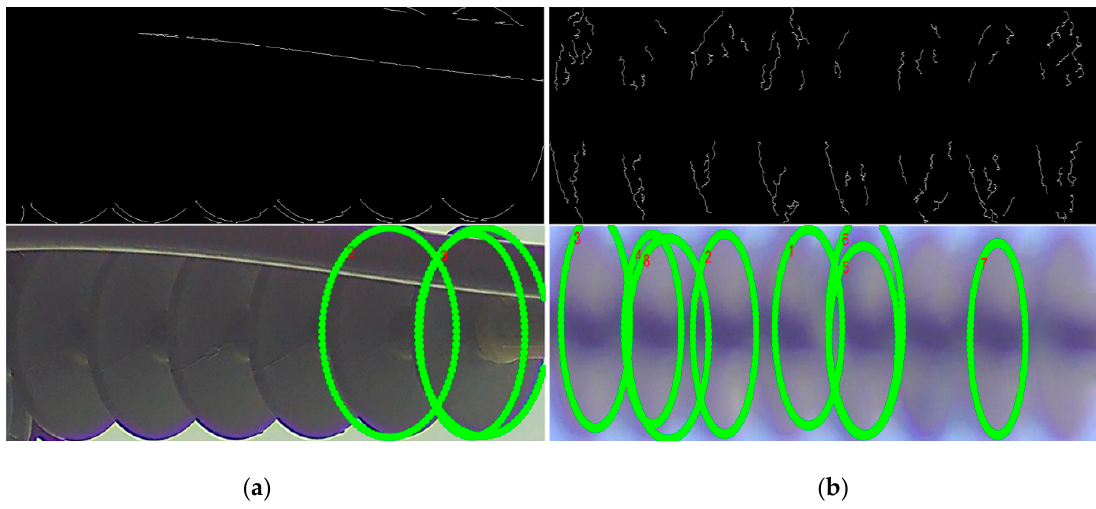
Figure 12. Robustness of ellipse detector depends upon the edges response. The figure shows two ellipse detection results along with their input edge responses. ( a ) The edges of the caps are occluded by the wire passing in front of the insulator, ( b ) while the blurry image resulted in a noisy edge map, and subsequent noisy detection